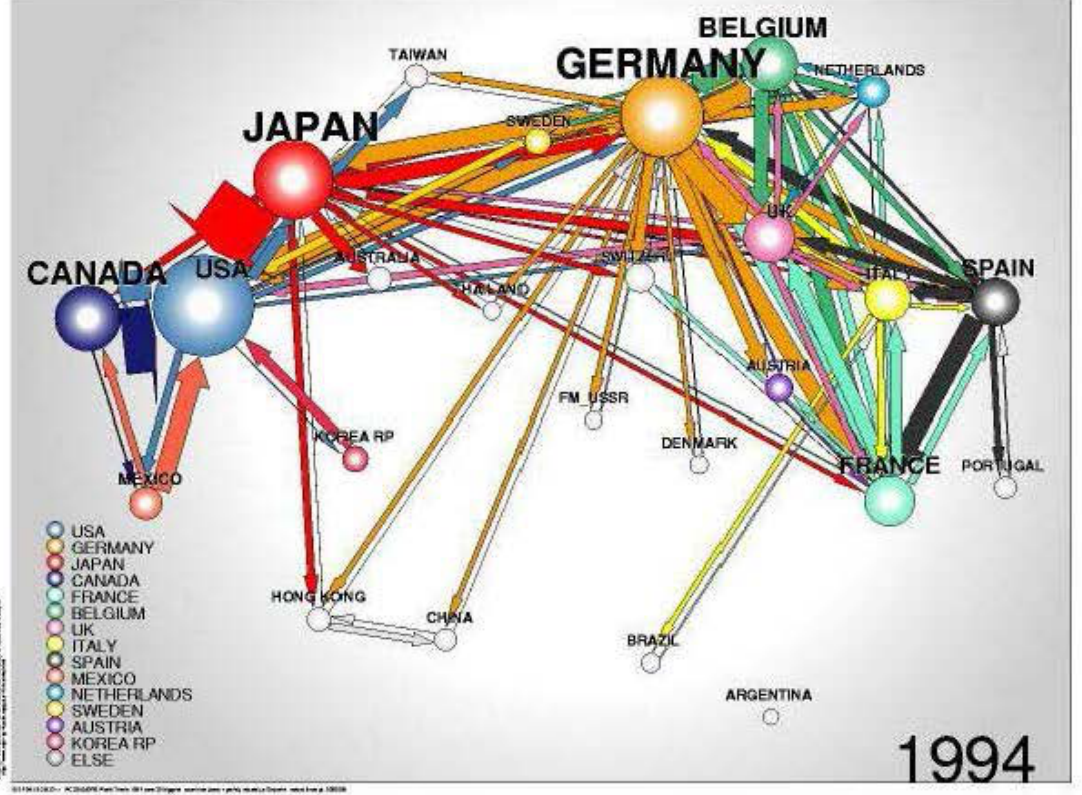
Figure 2:Thc World Trade in Cars for 1_980 (!ii and 1994 (b) forthc .25 Most linportant